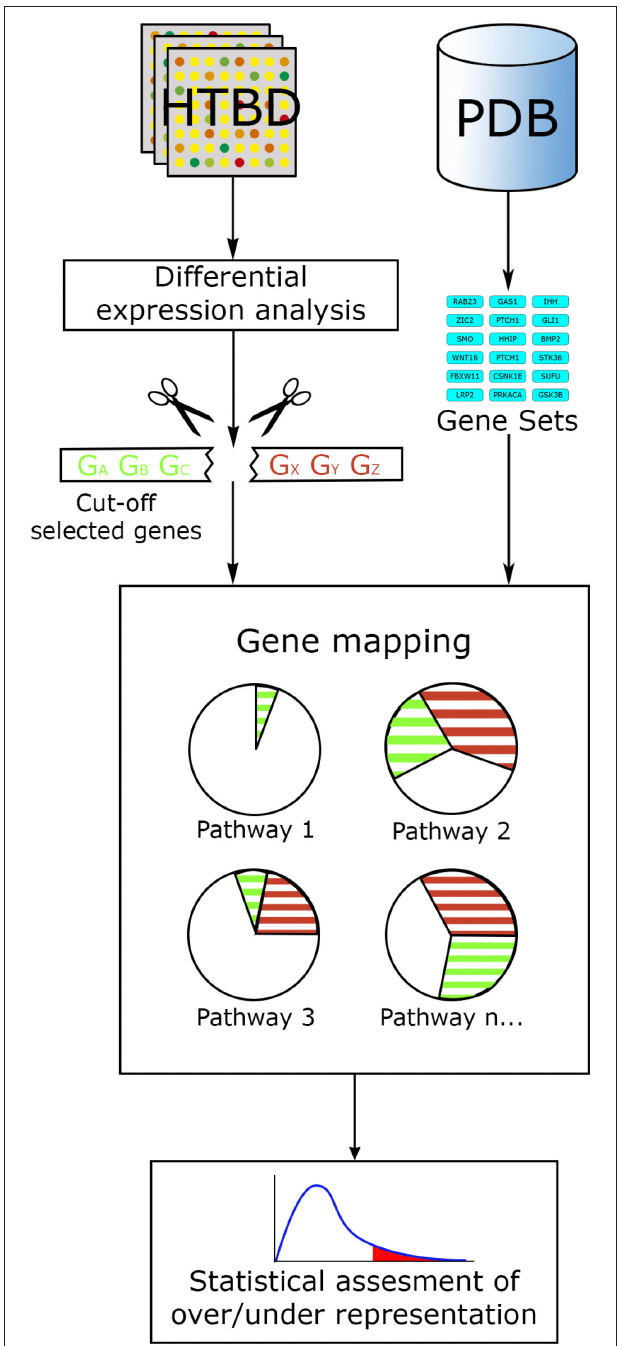
FIGURE 3 | ORA general workflow. The main input for ORA methods is information from HTBD in the form of cut-off lists derived from expression analysis, and the pathway data in gene set format. Selected genes are mapped in the pathways, and statistical assessment of each pathway is performed using different